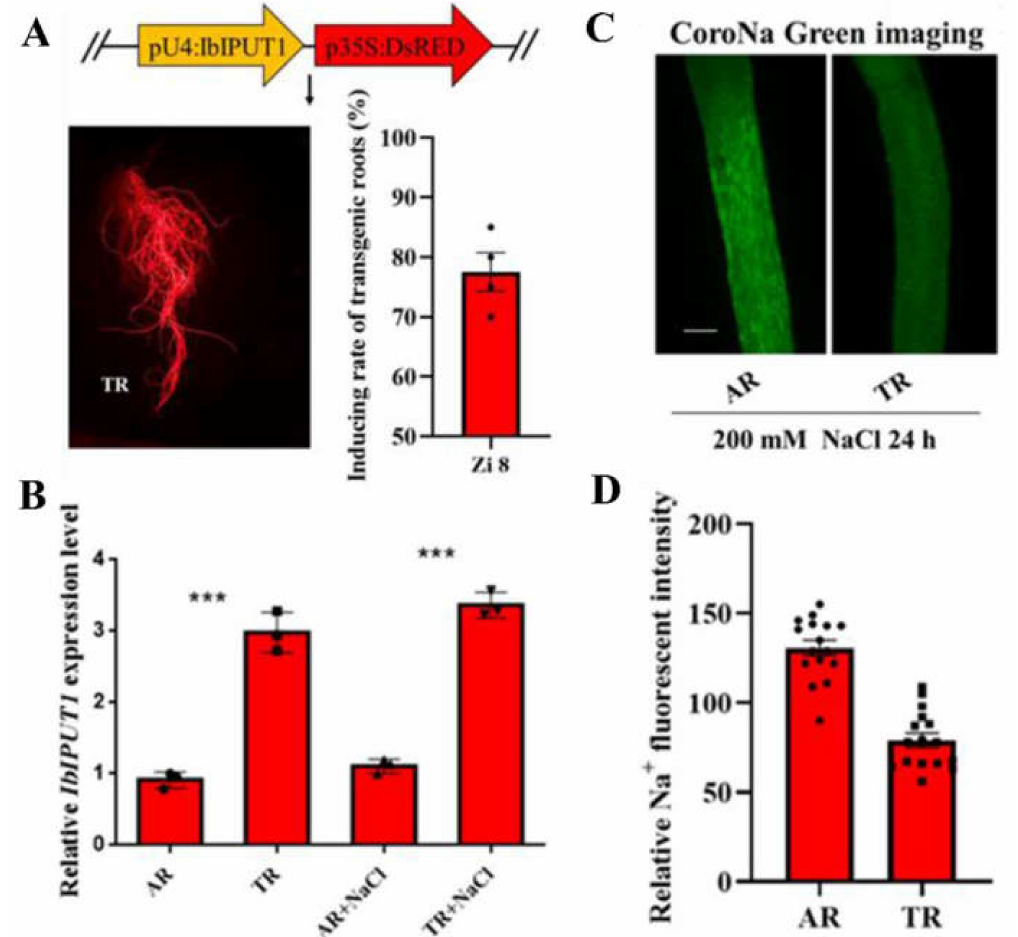
Figure 2. Overexpression of IbIPUT1 influences cellular Na + homeostasis in sweet potato roots. ( A ) Schematic of IbIPUT1 expression cassette and representative images showing the IbIPUT1 - transgenic roots (TRs) and non-transgenic adventitious roots (ARs) in the same seedling. Quantifi- cation of the transgenic rate of the vector in Zi 8 ( n = 4). ( B ) The relative expression of IbIPUT1 in transgenic roots (TRs) and adventitious roots (ARs). Internal reference: GAPDH . ( C ) Na + accumula- tion in elongation root zone of ARs and TRs, as visualized through CoroNaTM Green (200 mM NaCl for 24 h). Bar = 0.3 mm. ( D ) Quantification of Na + fluorescent intensity in ( C ) by using the Image-Pro Plus 6.0 software. Columns labeled with “***” indicate significant difference at p <